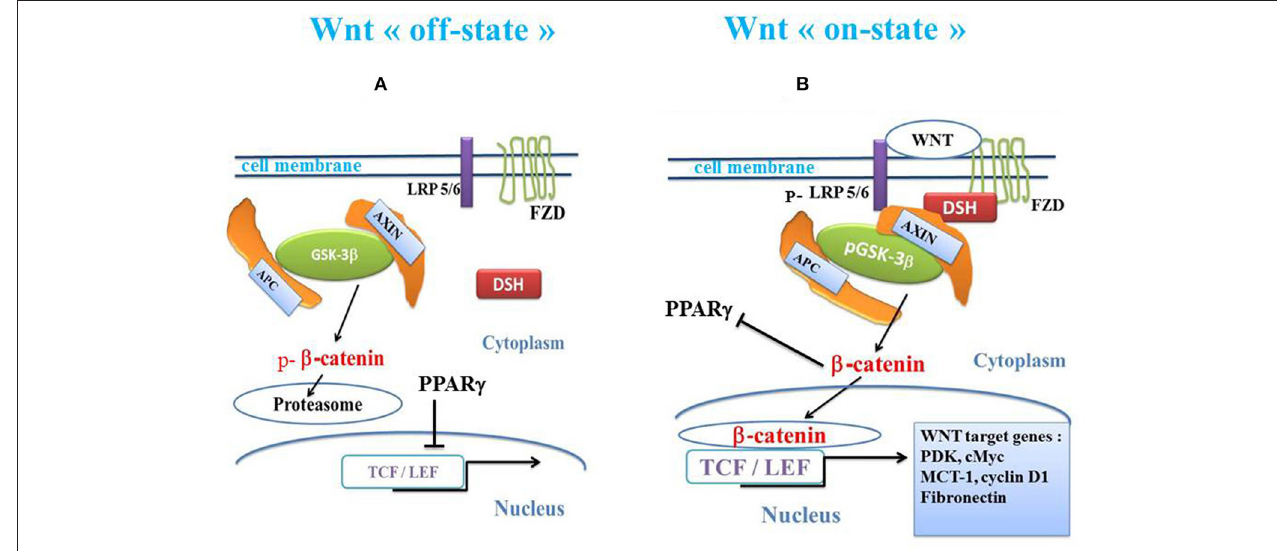
FIGURE 1 | Schema of canonical Wnt/ β -catenin pathway and PPAR γ . (A) In the absence of the WNT ligands (“off state”), cytosolic β -catenin is phosphorylated by GSK-3 β . APC and AXIN combine with GSK-3 β . Thus, p- β -catenin induces the destruction process and migrates to the proteasome. PPAR γ inhibits the β -catenin /TCF-LEF-induced activation of the Wnt target genes. (B) In the presence of the Wnt ligands (“on state”), a Wnt agent binds both Frizzled and LRP5/6 receptors to initiate LRP phosphorylation and disheveled-mediated Frizzled internalization. GSK-3 β is phosphorylated and β -catenin phosphorylation is inhibited, which prevents its degradation into the proteasome. Thus, β -catenin accumulates in the cytosol and translocates to the nucleus to bind TCF-LEF co-transcription factors. This induces the Wnt-response gene transcription (PDK, MCT-1, Myc, Cyclin D1, fibronectin). β -catenin inhibits PPAR γ . APC, adenomatous polyposis coli; DSH, Disheveled; FZD, Frizzled; GSK-3 β , glycogen synthase kinase-3 β ; LRP5/6, low-density lipoprotein receptor-related protein 5/6; PPAR γ , peroxisome proliferator-activated receptor gamma; TCF/LEF, T-cell factor/lymphoid enhancer factor; MCT-1, monocarboxylate lactate